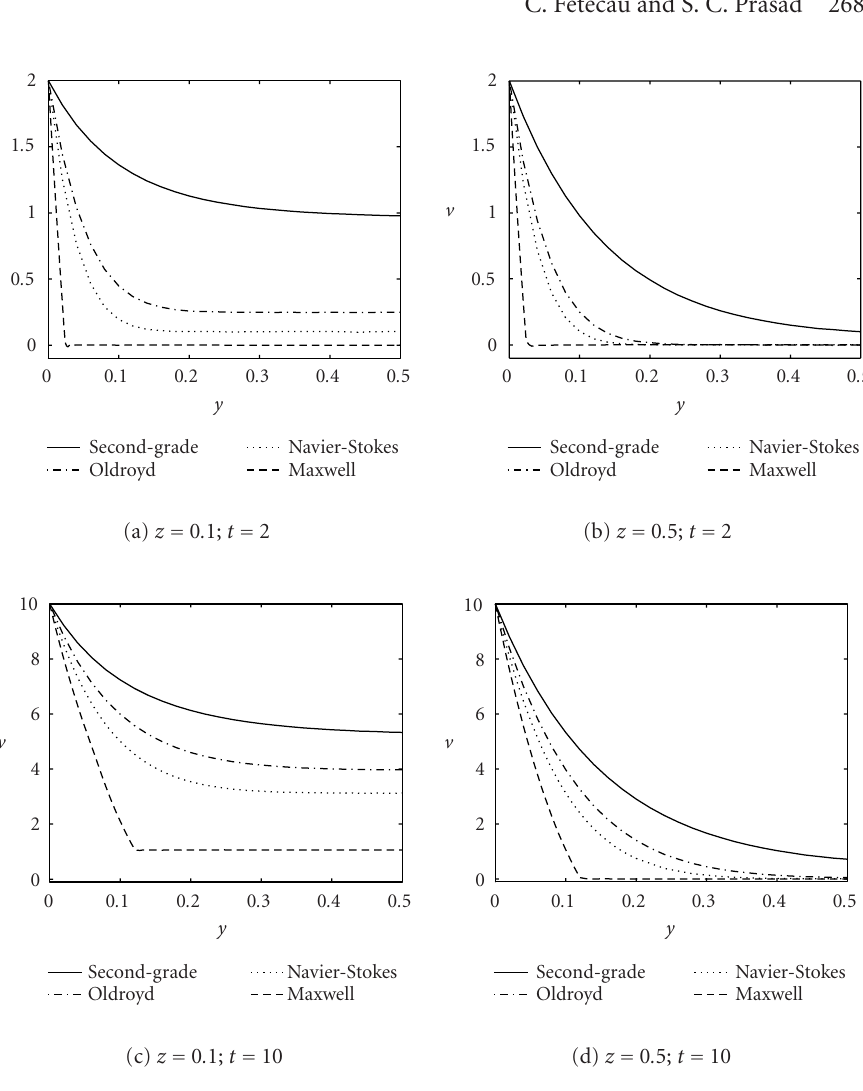
Figure 5.2. Velocity profiles v corresponding to a second-grade, Oldroyd, Navier-Stokes, and Maxwell fluid for A = 1 . 0, ν = 0 . 0011746, λ r = 15 and λ = 8, for z = 0 . 1 and z = 0 . 5cm, and t = 2 and 10s,